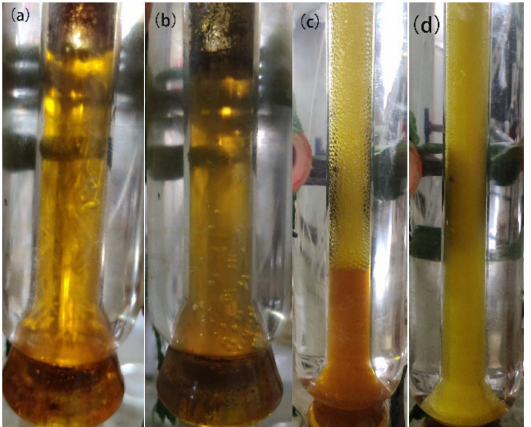
Figure 7. Photographic images of the bubble column reactors containing NC ( a , b ) and Zr 5 /NC ( c , d ) before and after the reaction.